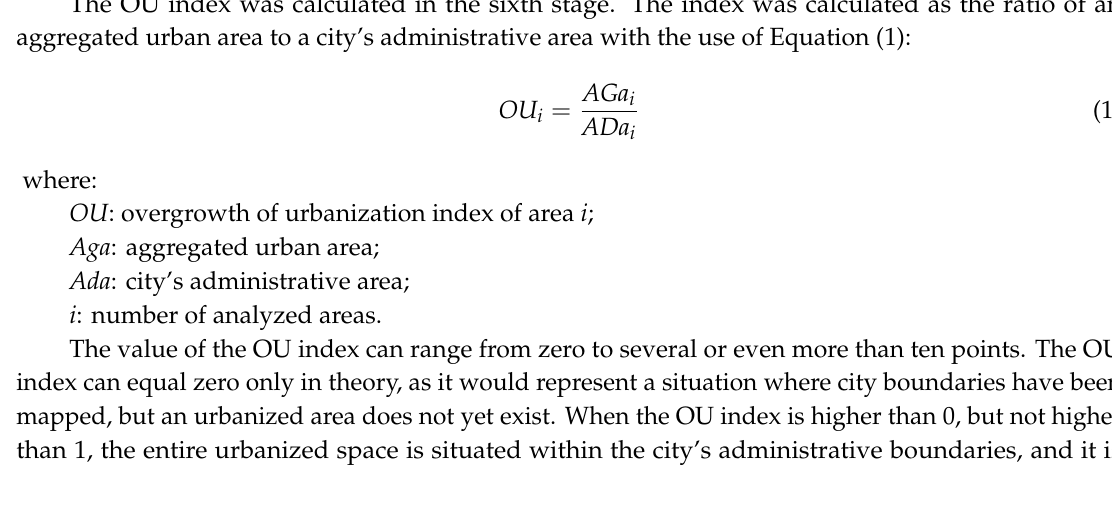
Figure 2. Procedure of calculating the overgrowth of urbanization (OU) index and verifying the results.